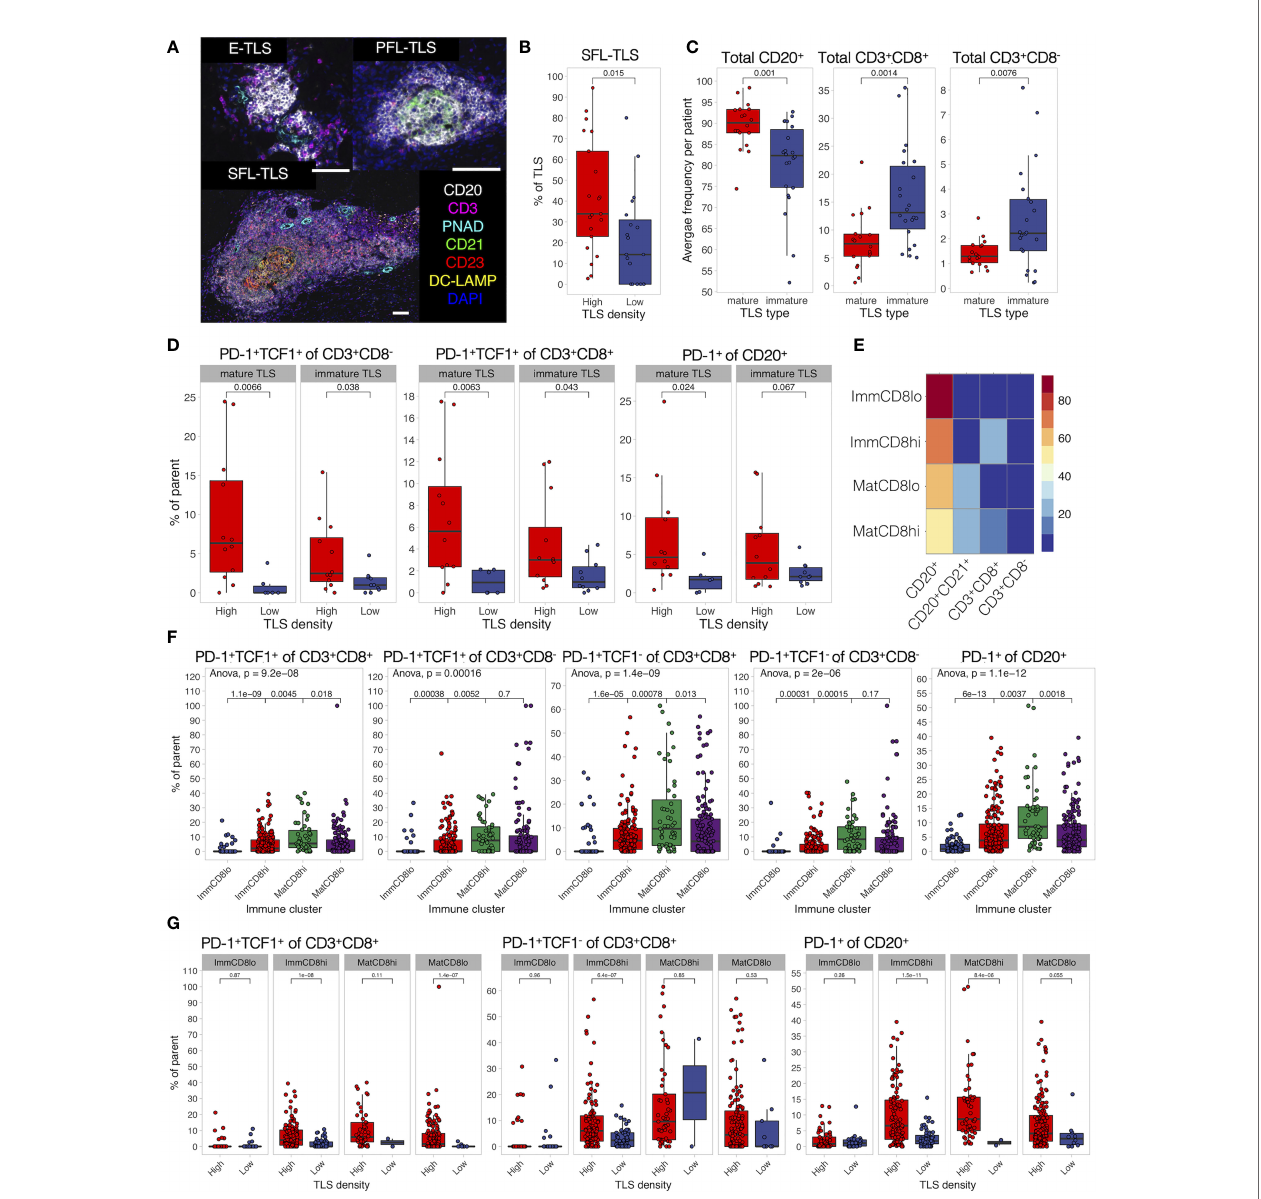
FIGURE 7 | TLS composition depends on TME and differs between maturation clusters. (A) TLS quanti fi cation and assessment of maturation was performed by mIF staining of CD20 (B cells), CD21 (FDCs), CD3 (total T cells), CD23 (GC cells), PNAd (high endothelial venules), and DC-LAMP (antigen-presenting DCs). Images were acquired by multispectral microscopy from all TLS. Tissue segmentation was used to detect FDC and GC presence in TLS for the assignment of TLS maturation stages as follows: no FDC and GCs — early TLS (E-TLS), FDC networks present but no GC cells — primary follicle-like TLS (PFL-TLS), GC cells present in FDC network — secondary follicle-like TLS (SFL-LS). Representative images of each maturation stage are shown. Scale bar = 100 m m. (B) The proportion of each TLS maturation stage was assessed as percentage of total TLS in each patient. The proportion of GC-containing TLS (SFL-TLS) was compared between TLS-high and TLS-low patients. (C) Characterization of immune cell in fi ltration in TLS was performed by mIF staining as described in Figure 5 . Presence of CD21+ cells was used to de fi ne a TLS as mature or immature. Frequencies of B cells and T cells were averaged per patient and compared between TLS maturation stages. (D) Proportions of PD-1 + TCF1 + progenitor-like cells from total CD8 - (left) and CD8 + (center) T cells, as well as PD-1 + cells from total B cells (right) were averaged per patient per TLS maturation stage and compared in TLS-high and TLS-low groups. (E) Hierarchical clustering was used to identify TLS with similar composition based on B-cell, CD21 + B-cell, and T-cell frequencies. Four clusters (TLS subtypes) were identi fi ed as follows: immature TLS with high or low CD8 + T-cell in fi ltration (ImmCD8hi and ImmCD8lo, respectively), and mature TLS with high or low CD8 + T-cell in fi ltration (MatCD8hi and MatCD8lo, respectively). Heatmap displays the average frequency of the measured cell populations in the identi fi ed TLS subtypes. (F) Proportions of PD-1-expressing lymphocytes and PD-1 + TCF1 + progenitor-like T cells were compared in different TLS clusters. (G) Proportion of PD-1 + TCF1 + progenitor-like CD8 + T cells, PD-1 + B cells, and CD8 + T cells was measured in each individual TLS and compared between different TLS density groups for each TLS subtype separately. In all panels, two groups (as indicated by group connectors below p -values) were compared by two-tailed t -test without correction for multiple testing. More than two groups were compared by one-way